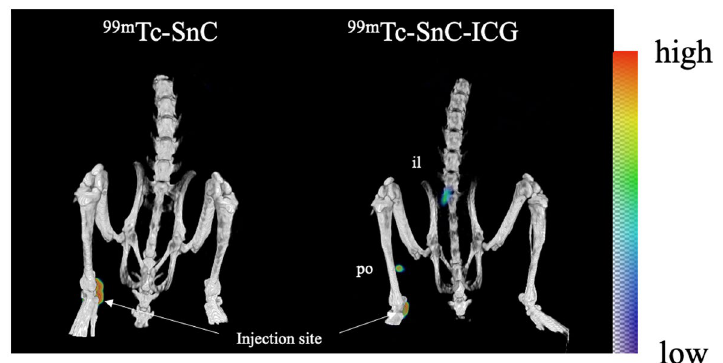
Figure 4. Biodistribution analysis of technetium-99m–stannous colloid ( 99m Tc-SnC) or 99m Tc-SnC–indocyanine green mixed tracer ( 99m Tc-SnC–ICG) in rats using single positron emission computed tomography and X-ray computed tomography. Radioactivity of the accumulation site on the images is indicated with a color gradient shown in the rightmost.